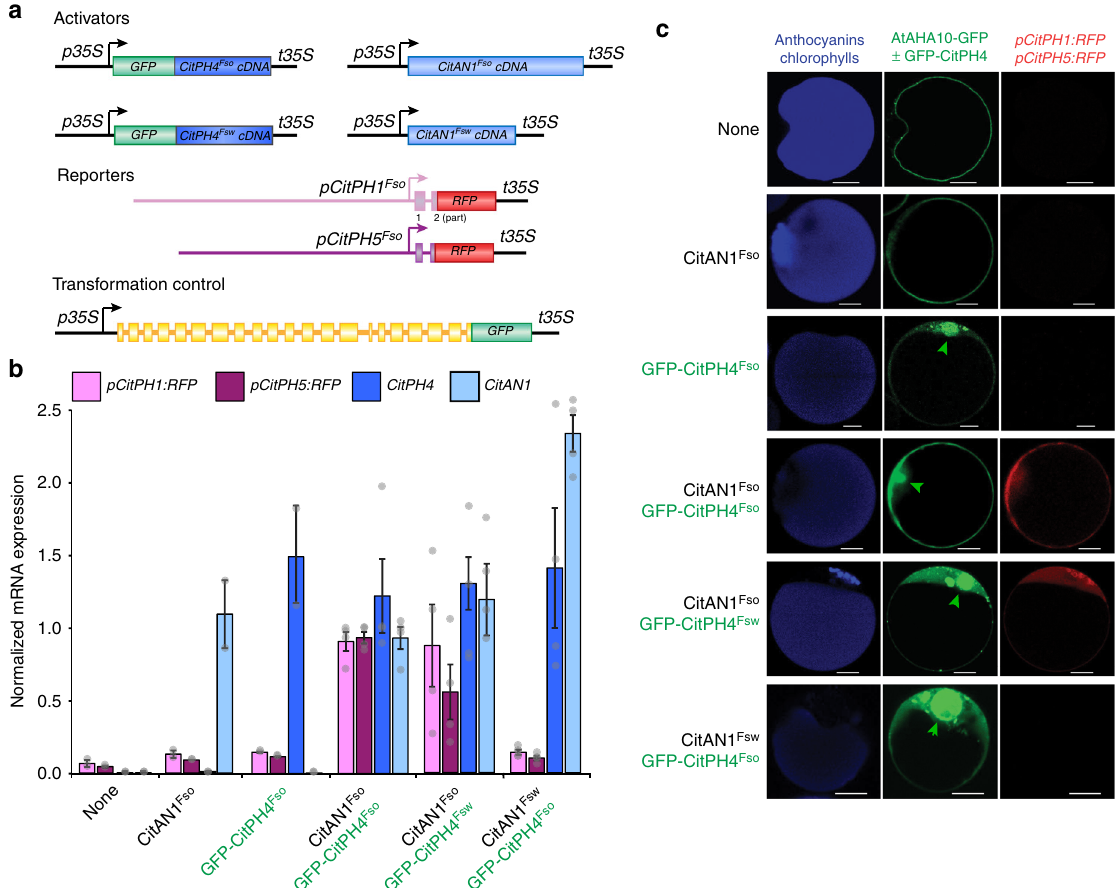
Fig. 2 Activation of CitPH1 and CitPH5 promoters by CitAN1 and CitPH4. a Structure of effector, reporter, and control genes used for transient transformation of protoplast from the epidermis of petunia ph4 petals. b Relative expression (real-time RT-PCR of effector ( CitAN1 and CitPH4 ) and reporter ( pCitPH1:RFP and pCitPH5:RFP ) mRNA expression in petal protoplasts transformed with different effectors [mean ± SE from 2 technical PCR replicates of 4 independent transformation experiments ( n = 4 × 2)]. Expression of the co-transformed 35S:AHA10-GFP gene was used for normalization. c Confocal micrographs of petunia ph4 epidermal petal protoplasts, with anthocyanins in the central vacuole, from stage 6 fl owers, 24 h after transformation of 35S:AHA10-GFP , the reporters pCitPH1:RFP , pCitPH5:RFP , and different combinations of the effectors 35S:GFP-CitPH4 Fso , 35S:GFP- CitPH4